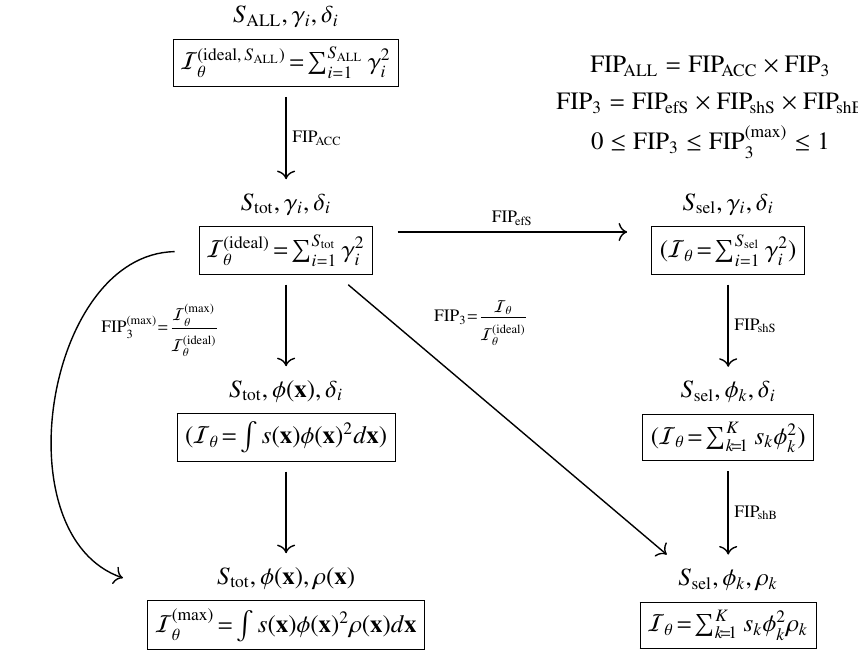
Figure 1. Graphical representation of FIP metrics and of their inter-relationships. For each of the seven scenarios considered, the number of signal events used and the resolution on signal sensitivity γ i and on signal / background classification δ i (where δ i = 1 and δ i = 0 for true signal and background events, respectively) are reported, as well as the information The main FIP metric discussed in this paper is FIP 3 = and FIP shB . While theoretically FIP 3 is a metric in [0,1], for a realistic detector FIP 3